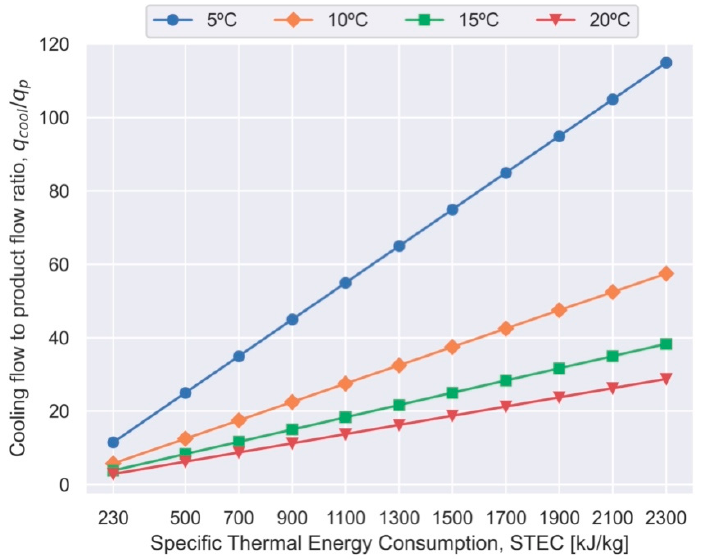
Figure 5. Ratio of cooling flow (q cool ) to product flow (q p ) versus the specific thermal energy consumption (STEC) of a thermal desalination plant, considering a temperature increase of the colling flow from 5 to 20 °C.